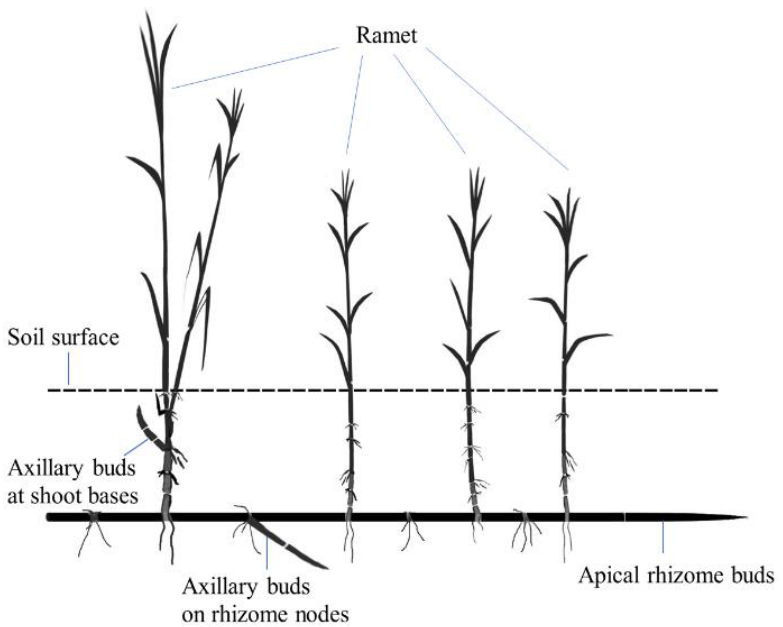
Figure 4. Schematic representation of belowground and aboveground organs in Phragmites communis .